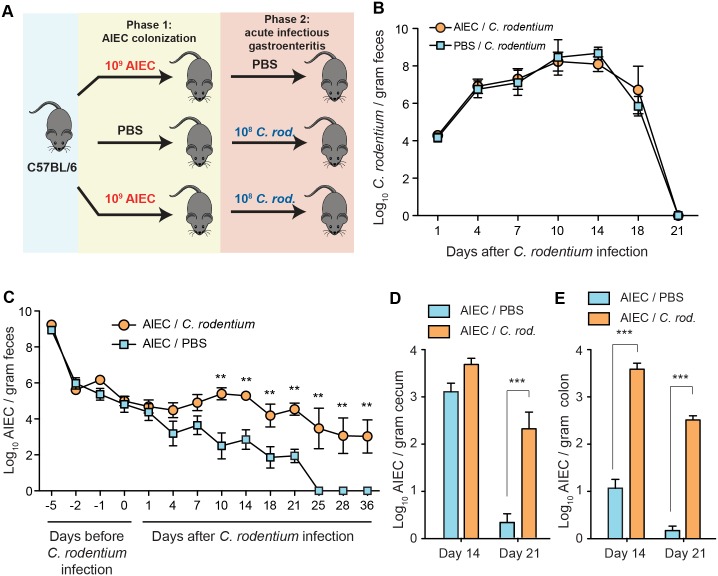
Infectious colitis by C. rodentium prevents convalescence from AIEC colonization.(A) Infection scheme. C57BL/6 mice colonized with 2 x 109 cfu AIEC NRG857c for 7 days or treated with PBS and then infected with 1 x 108 cfu C. rodentium or given PBS. (B) Fecal shedding of C. rodentium was monitored for 21 days. Data are means ± SEM of at least 5 mice per group/time point from 3 independent experiments. (C) Fecal shedding of AIEC after C. rodentium infection was monitored for 36 days. Data are means ± SEM of at least 5 mice per group/time point from 3 independent experiments. Tissue- associated AIEC was measured in the cecum (D) and colon (E) on day 14 and 21 after C. rodentium infection. Data are means ± SEM of at least 5 mice per group/time point from 3 independent experiments. **p<0.01 and ***p<0.001 (Mann-Whitney test).